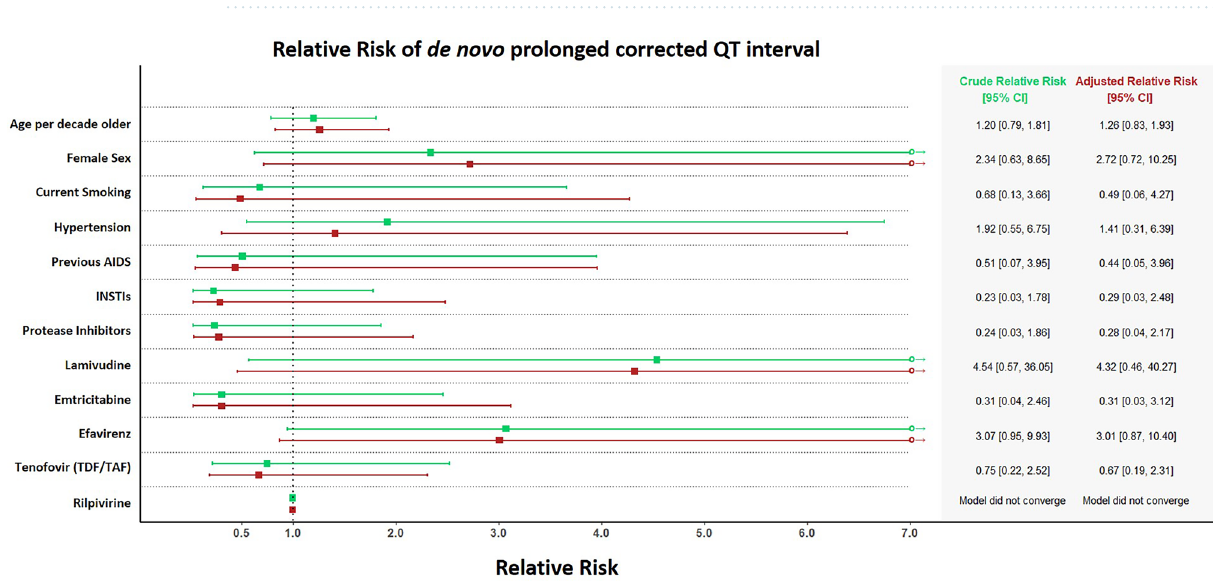
Figure 3. Relative Risk of de novo prolonged corrected QTc. Relative risk (RR) of de novo prolonged corrected QTc for the most commonly used antiretrovirals with 95% confidence intervals. Vertical dotted line represents an RR of 1. Green is crude (unadjusted) and red is adjusted for age, sex, smoking status, hypertension, body mass index (BMI), and diabetes. Age age at baseline, INSTI integrase nuclear strand transfer inhibitor, TDF Tenofovir disoproxil; TAF Tenofovir